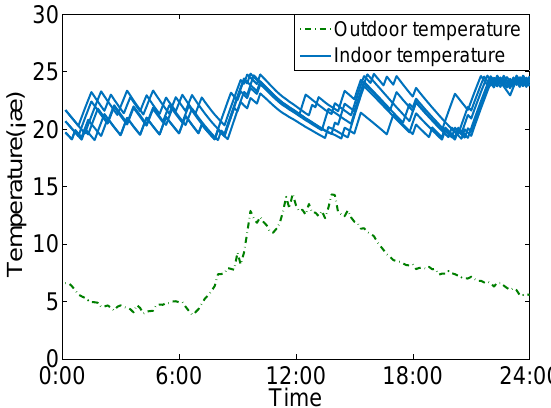
Figure 6. Comparison of outdoor temperature and indoor temperature.